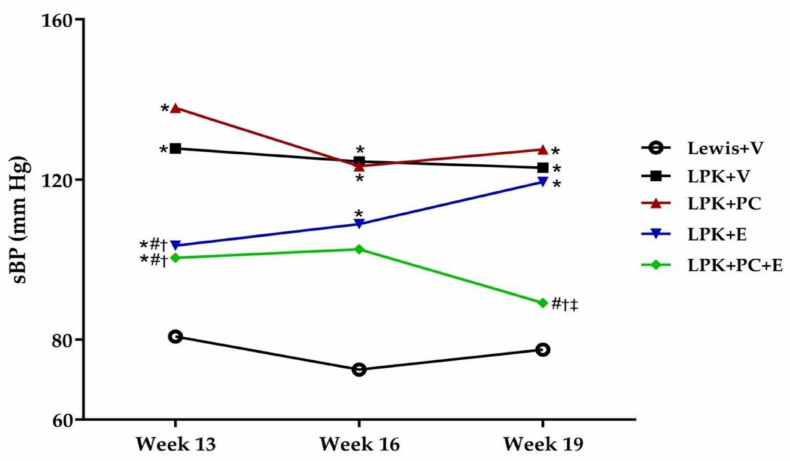
Figure 3. Effect of delayed paricalcitol treatment on the progression of hypertension in LPK rats. sBP, systolic blood pressure; LPK, Lewis polycystic kidney rat; V, vehicle; PC, paricalcitol; E, enalapril. Data represented as mean. * p < 0.05 compared to Lewis + V; # p < 0.05 compared to LPK + V.